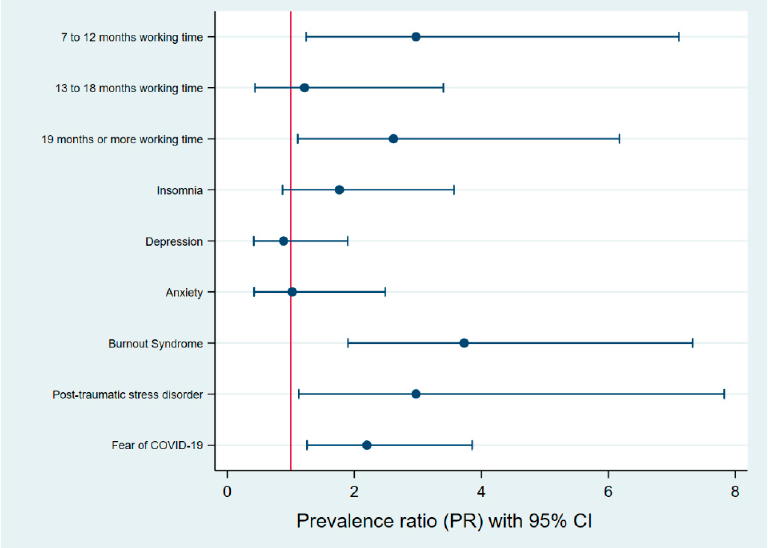
Figure 2. Forest plot of the factors associated with eating behavior in multiple regression analysis.